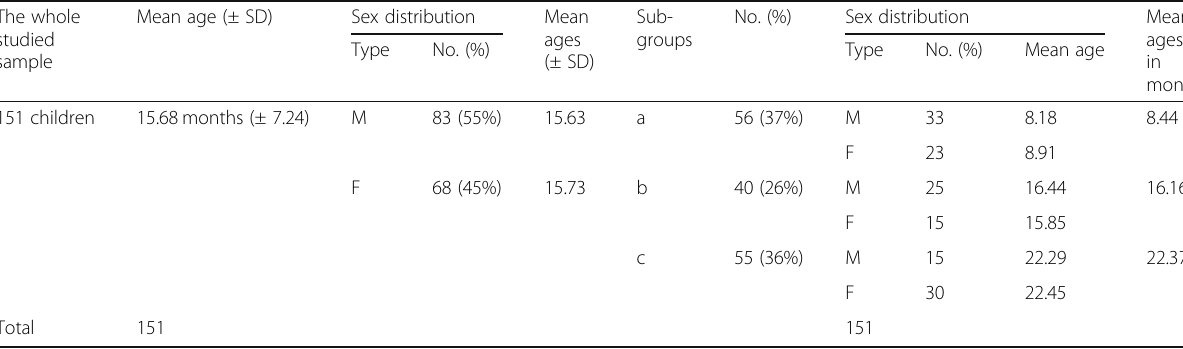
Table 5 Demographic data of the whole studied sample The whole studied